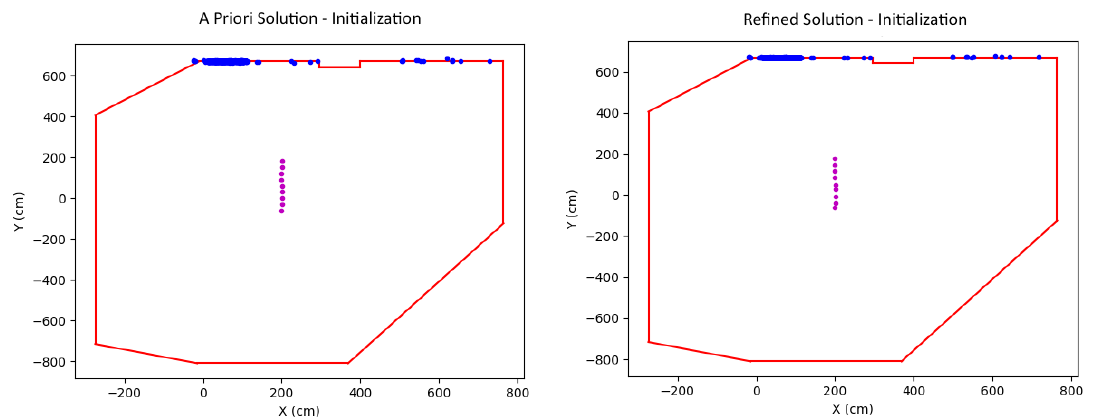
Figure 5. Initialization: scaled camera motion and world points before ( left ) and after ( right )